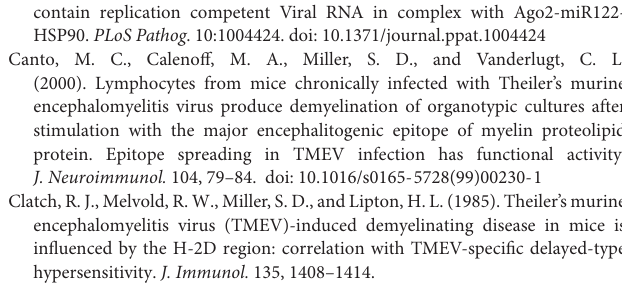
assay with BHK cells (E) . Plaque forming units were calculated as described above. Supplementary Figure 2 | Exosomes from TMEV-infected microglia have contents that activate bystander microglia in dose dependent manner within 4 h. Exosomes were isolated from TMEV-infected microglia or mock infected microglia. The exosomes from TMEV-infected microglia were quantified and placed on unstimulated microglia (1 × 10 6 ) at concentration of 200, 100, 20, or 2 µ g for 24 h. Microglia were lysed, RNA isolated, converted to cDNA, and analyzed by real time PCR for expression of TMEV (A) , IFN β (B) , and TNF α (C) . Exosomes were